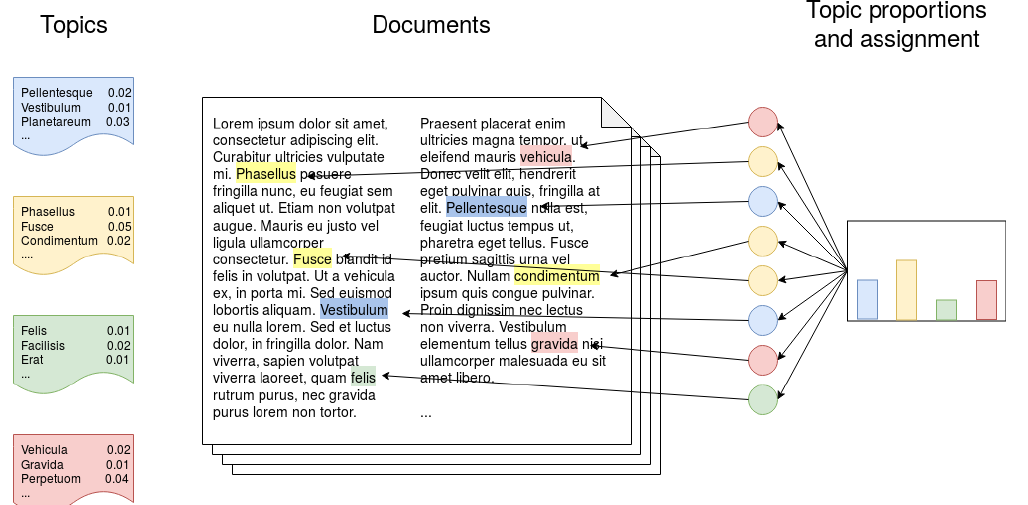
Figure 1. Collection of topics with distribution of words (left), document distribution over topics (histogram, right), and words sampled from the topics’ vocabularies (circles). The topics, words, and assignment are for illustrative purposes. Adapted from Blei